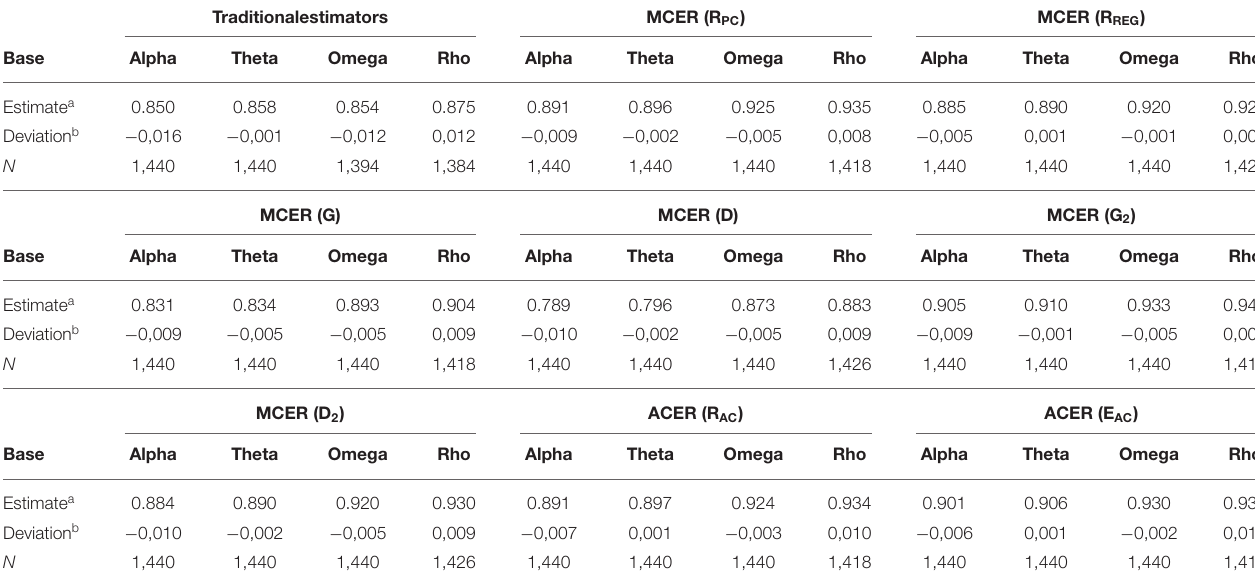
TABLE 1 | Average estimates of reliability and deviance from the population value in simulation. Traditionalestimators